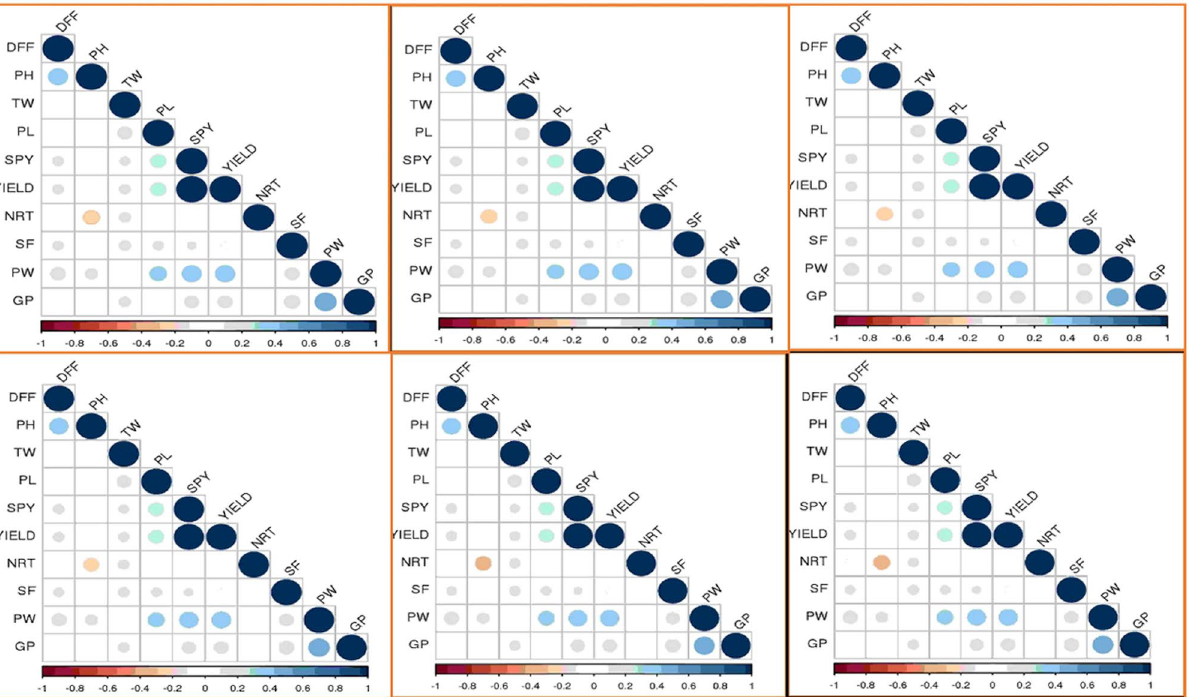
Figure 2. Phenotype correlation coefficient analysis using the Pearson method for all traits under study across the environments—E1A (Top Left), E1B (Top Middle), E1C (Top Right), E2A (Bottom Left), E2B (Bottom Middle), E2C (Bottom